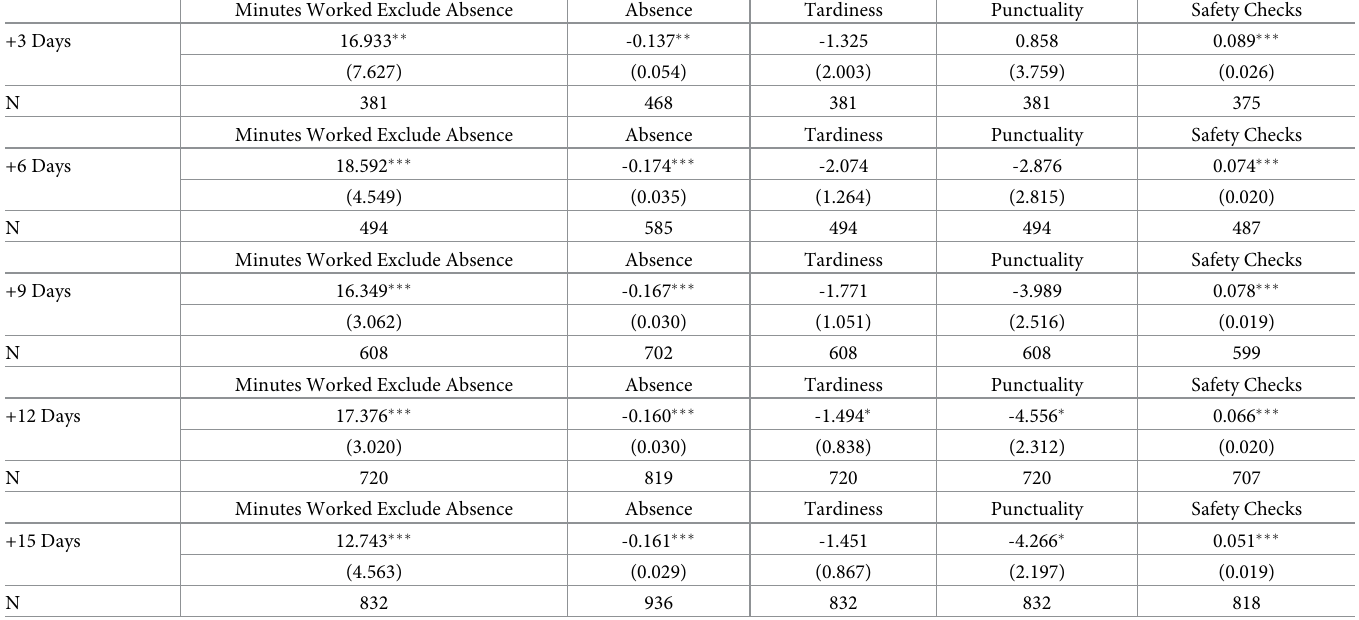
Table 2. Fixed effects